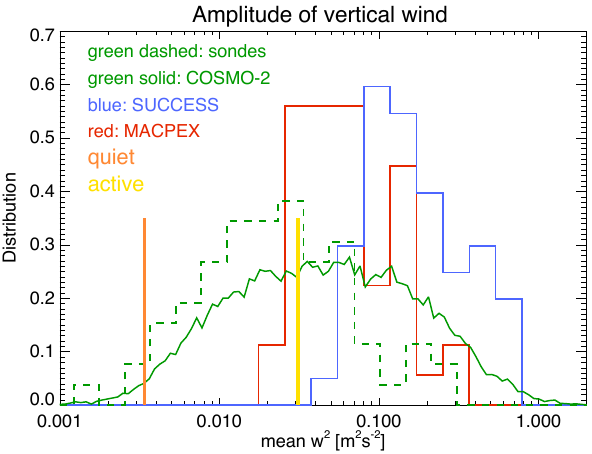
Figure 5. Normalized distribution (d f/ dln w 2 ) of hourly mean val- ues of w 2 . Blue and red: aircraft measurements during SUCCESS and MACPEX, respectively. Solid green line: daily mean w 2 in the COSMO-2 analysis for the Alpine region for the time period from 2010 to 2014. Dashed green line: distribution of vertical winds for 71 balloon soundings from Zurich and Payerne (Switzerland). Or- ange bar: mean vertical wind along the online trajectories on 22 November 2011. Yellow bar: mean w 2 along offline trajectories on an active day analysed in Appendix